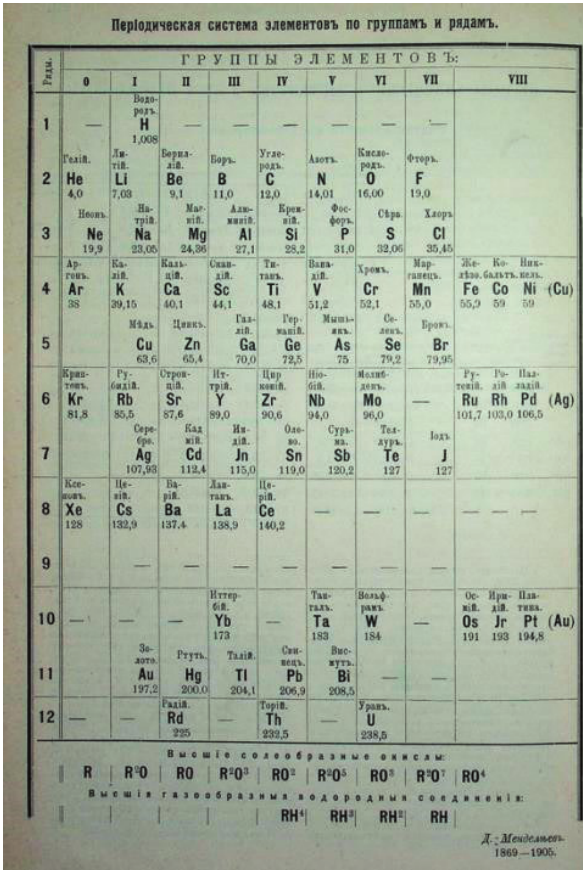
Figure 5. “Periodic System of the Elements» published in the book by D.I. Mendeleev “Fundamentals of Chemistry”. St. Petersburg. 1906.